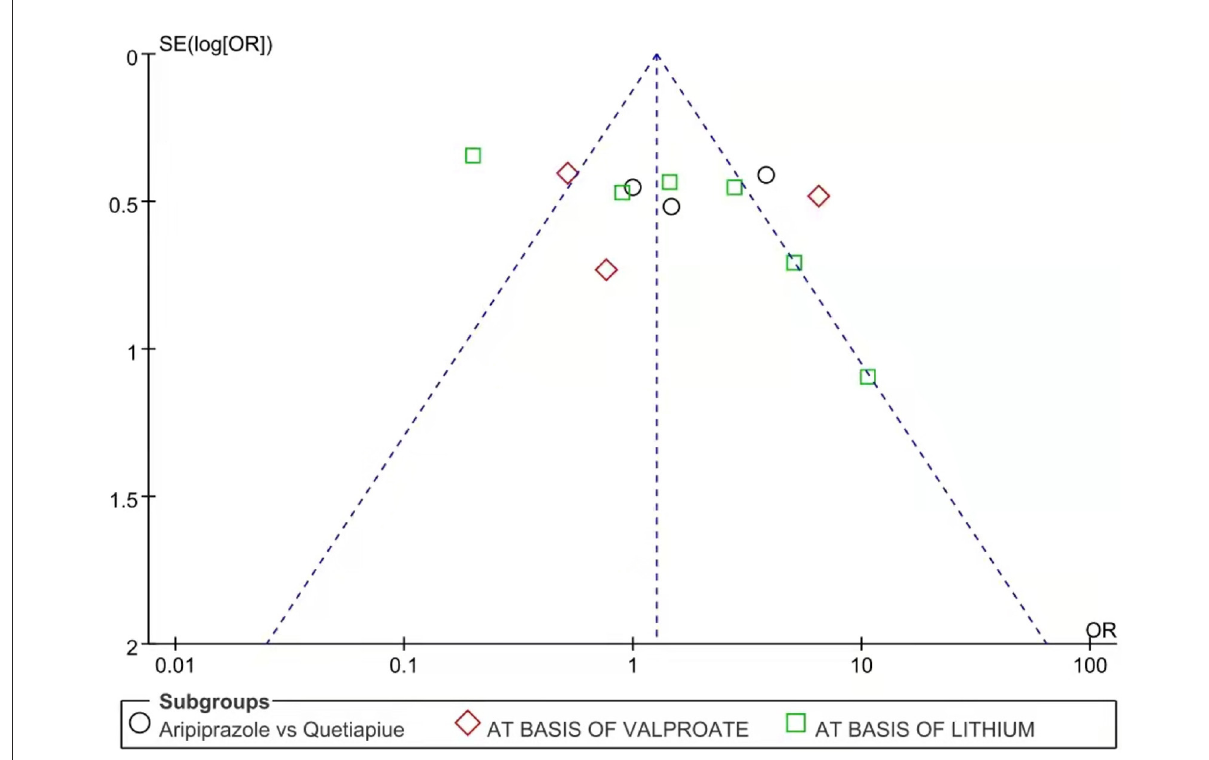
FIGURE7 Funnel plot of effective rate between aripiprazole and quetiapine in different case. There was no publication bias in these